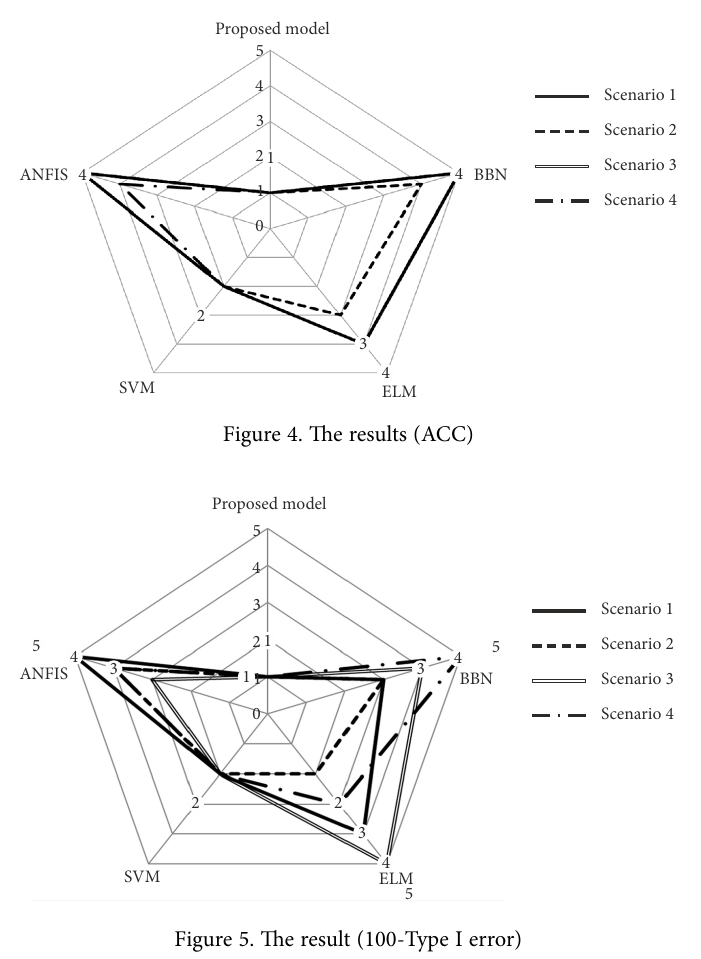
Figure 5. The result (100-Type I error)